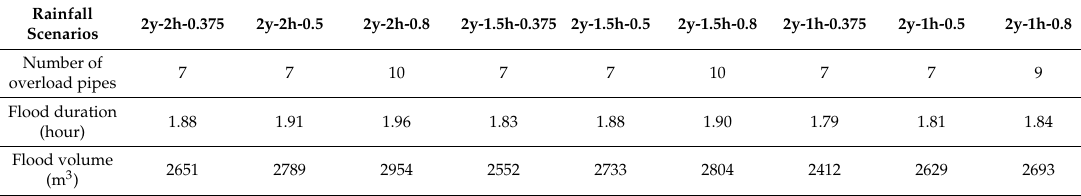
Table 5. Situation of drainage capacity under different rainfall scenarios.